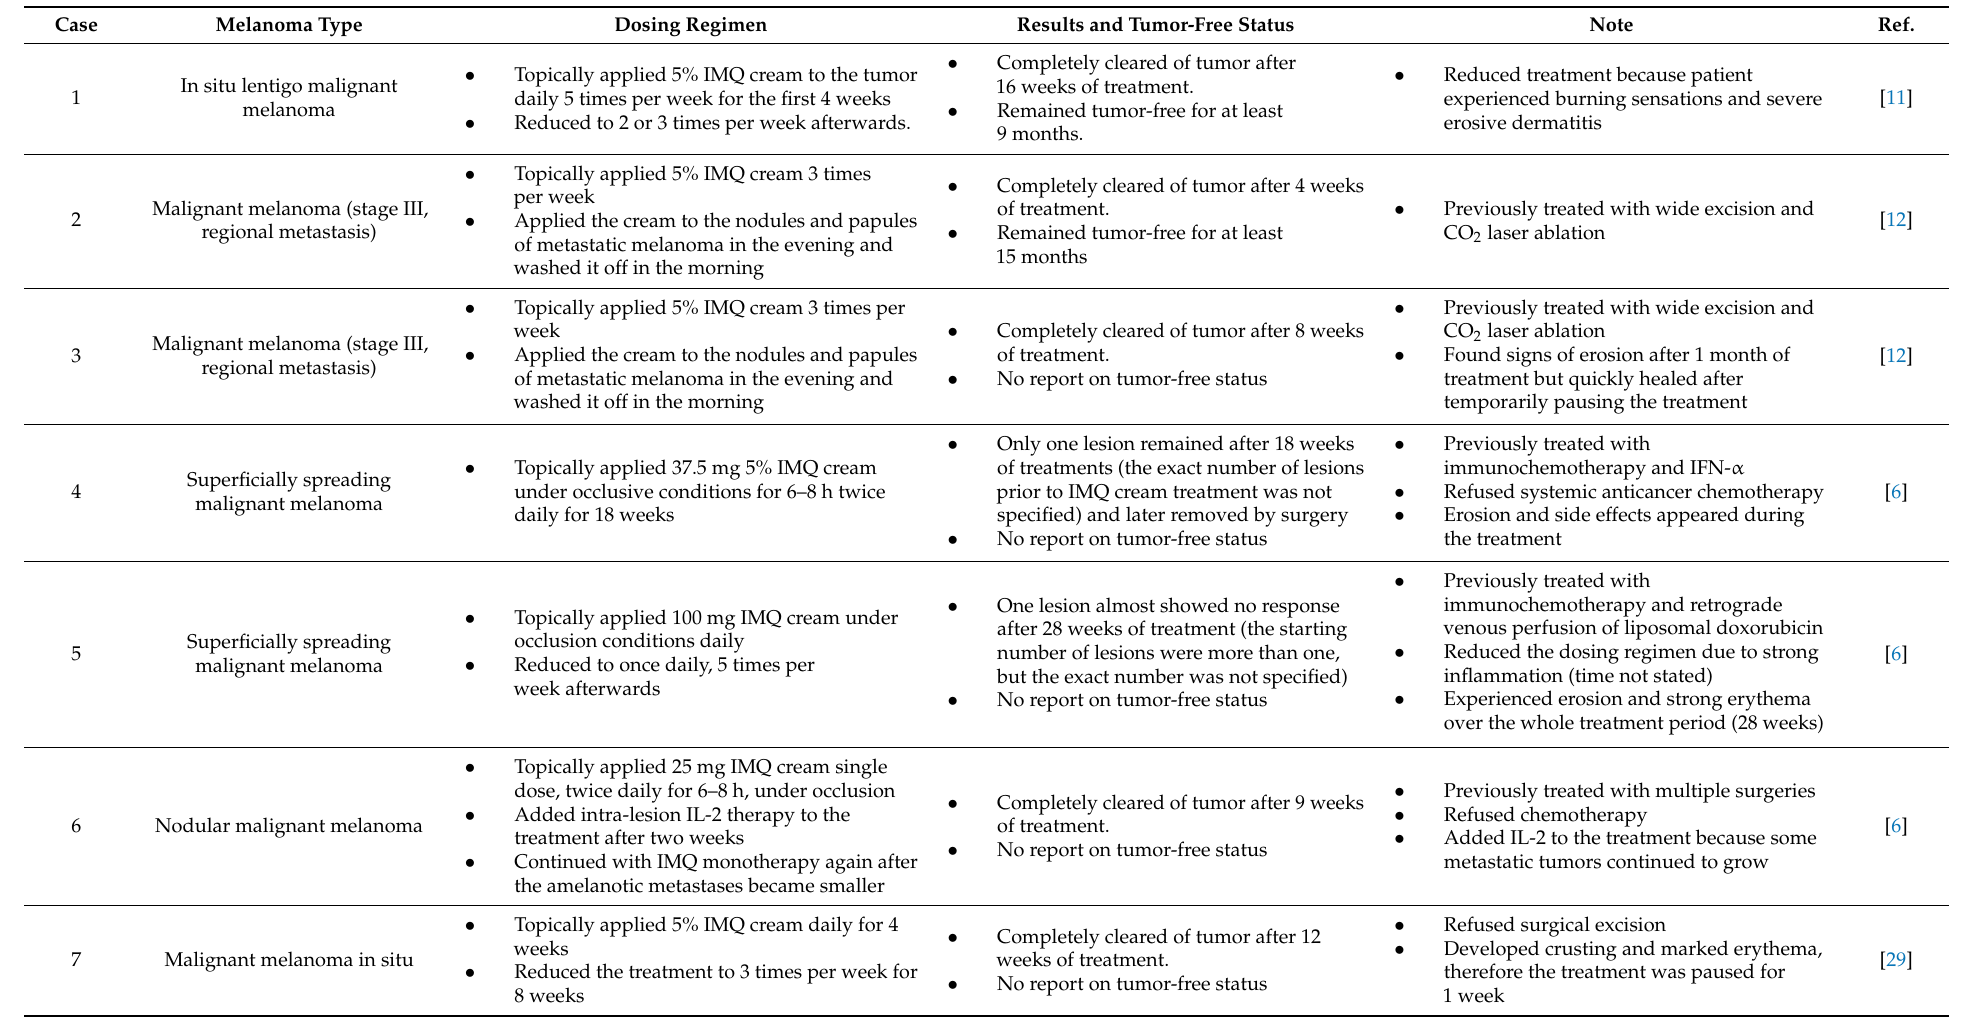
Table 2. Case reports on using IMQ cream to treat melanoma at different